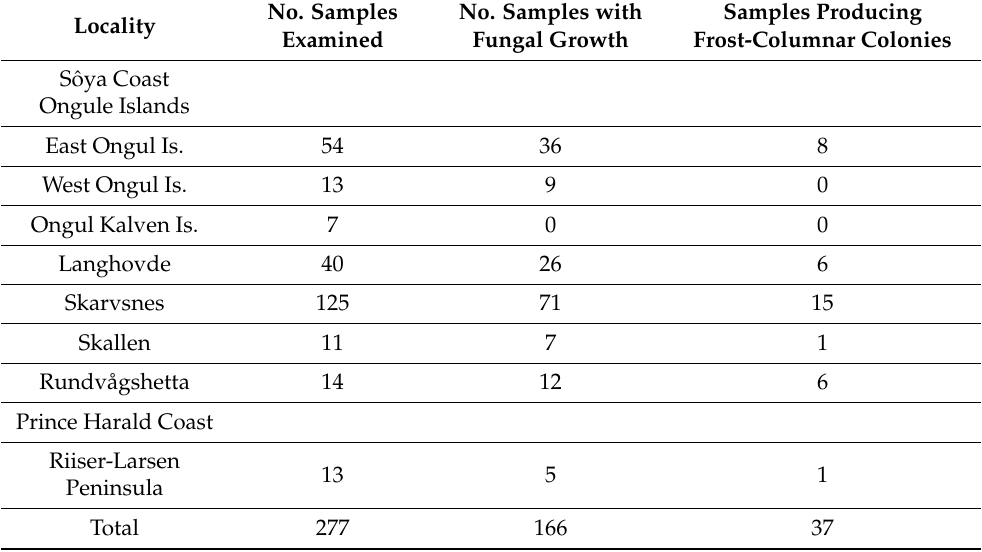
Table 1. The number of fungi that grew on frozen potato dextrose agar, including those that formed frost-columnar